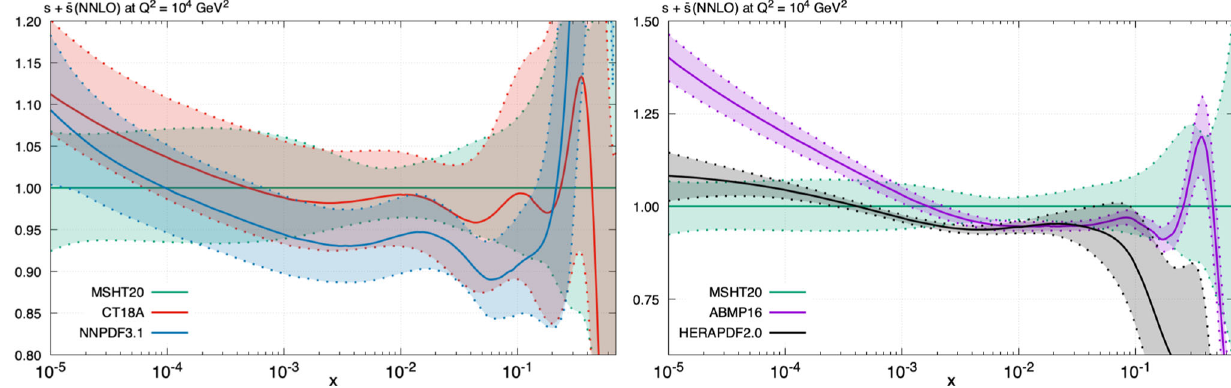
Fig. 94 Comparison of the MSHT20 NNLO s + s PDF at Q 2 = 10 4 GeV 2 with other representative PDF sets, presented as a ratio to the MSHT ) = 0 . 118 in all cases set. These correspond to α S ( M 2 Z